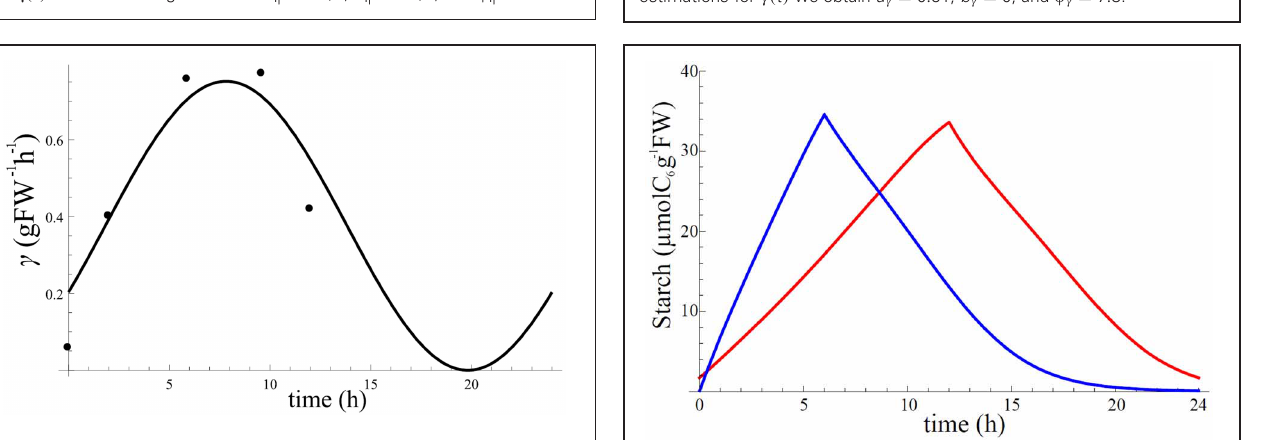
FIGURE A3 | Profile of oscillating η ( t ) after fitting to estimates (points) of η ( t ) . Obtained fitting values are a η = 3 . 3/h, b η = 0 . 6/h, and φ η = 5 . 5h.